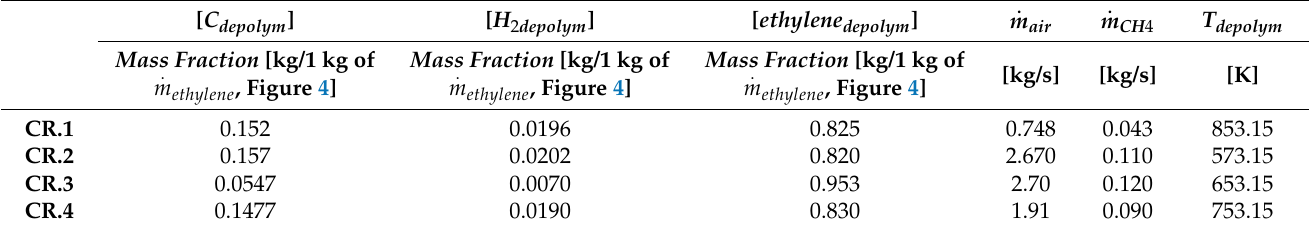
Table 7. Decision-making results: decision variables